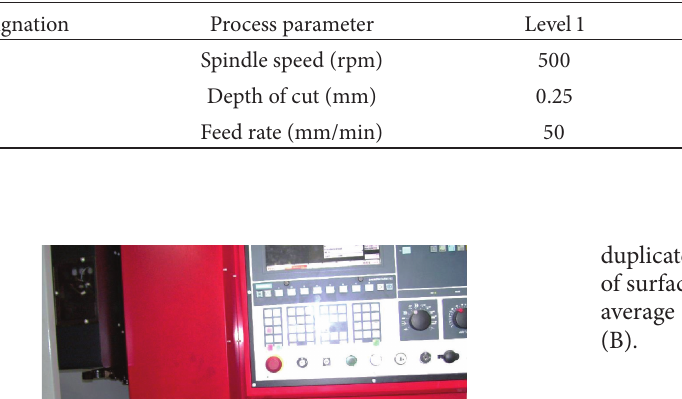
Table 2: The cutting parameters and their levels used in the factorial design experiment.